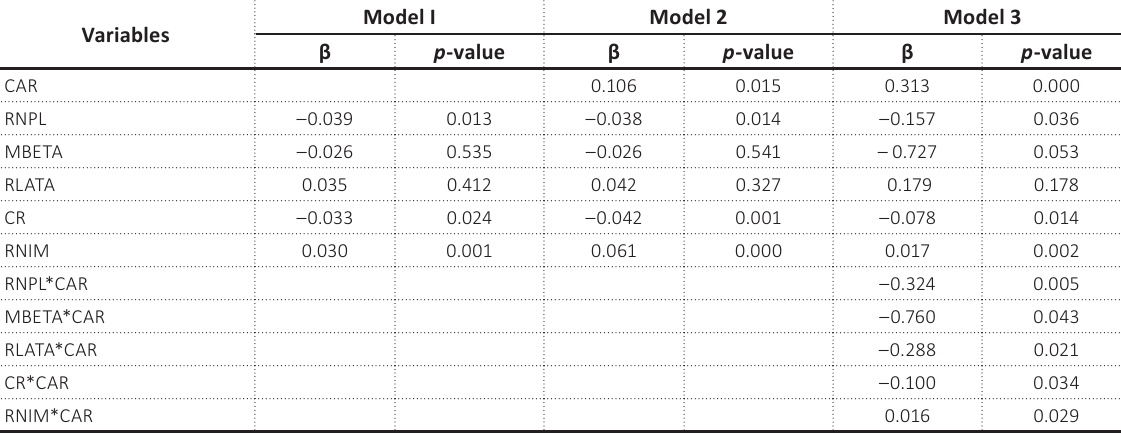
Table 7. Moderating effects of CAR on financial risks and Tobin’s